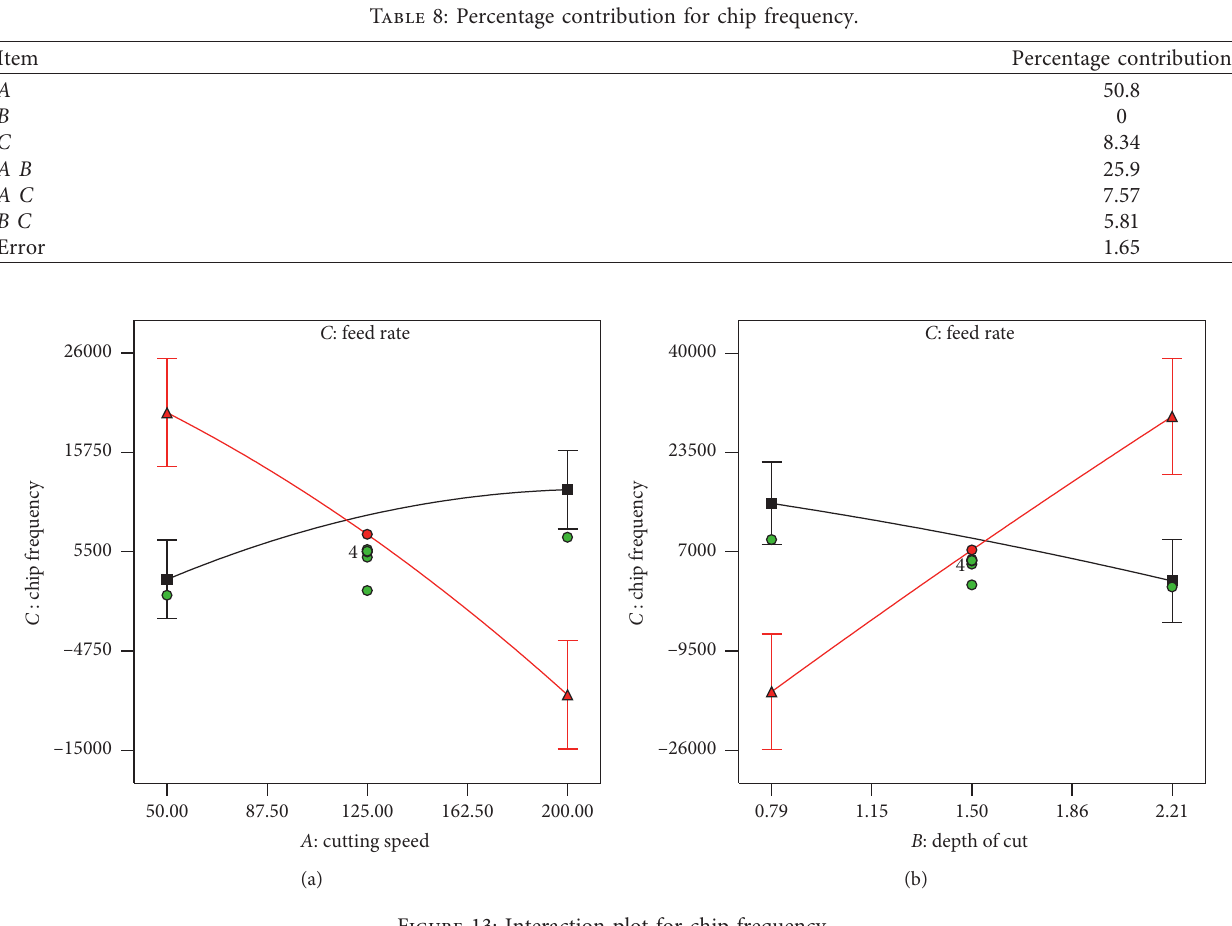
Figure 13: Interaction plot for chip frequency.